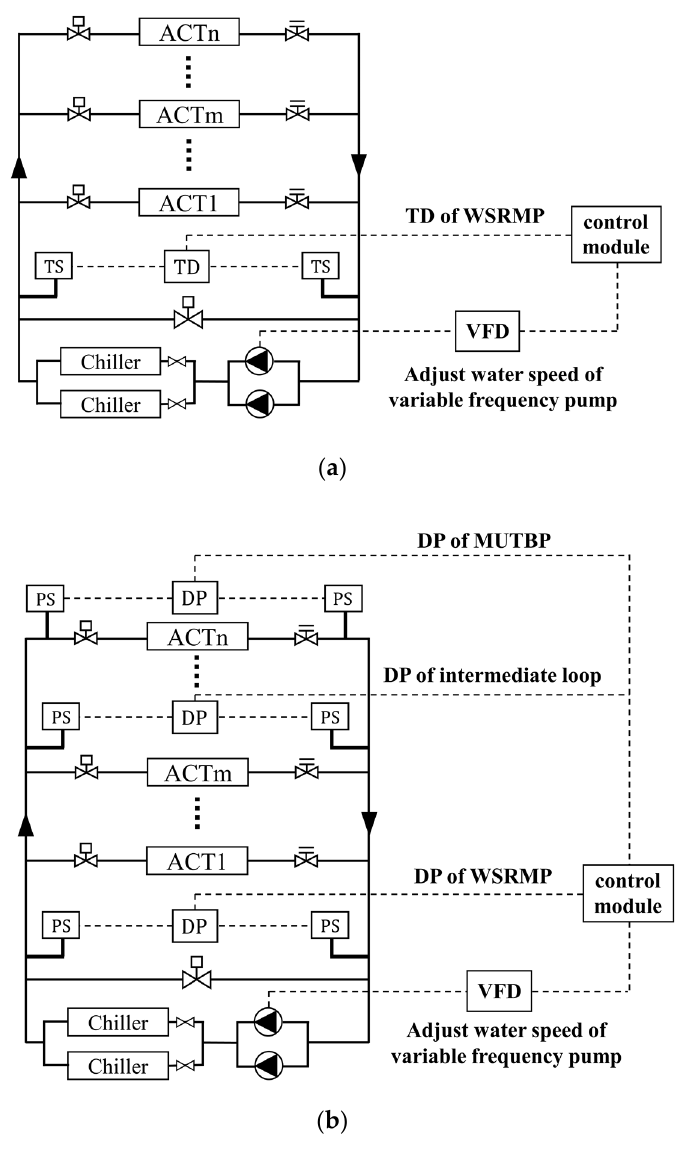
Figure 1. Common VWF control strategies in engineering: ( a ) the TD set-point control strategy; and ( b ) the DP set-point control strategy. ACT represents the air conditioner terminal; VFD represents variable frequency drivers; TD represents temperature di ff erence; TS represents temperature sensor; DP represents di ff erential pressure; and PS represents pressure sensor.